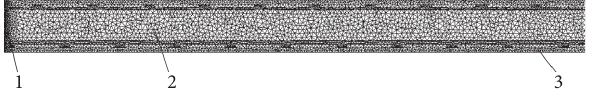
Figure 5: Meshing of slag discharge